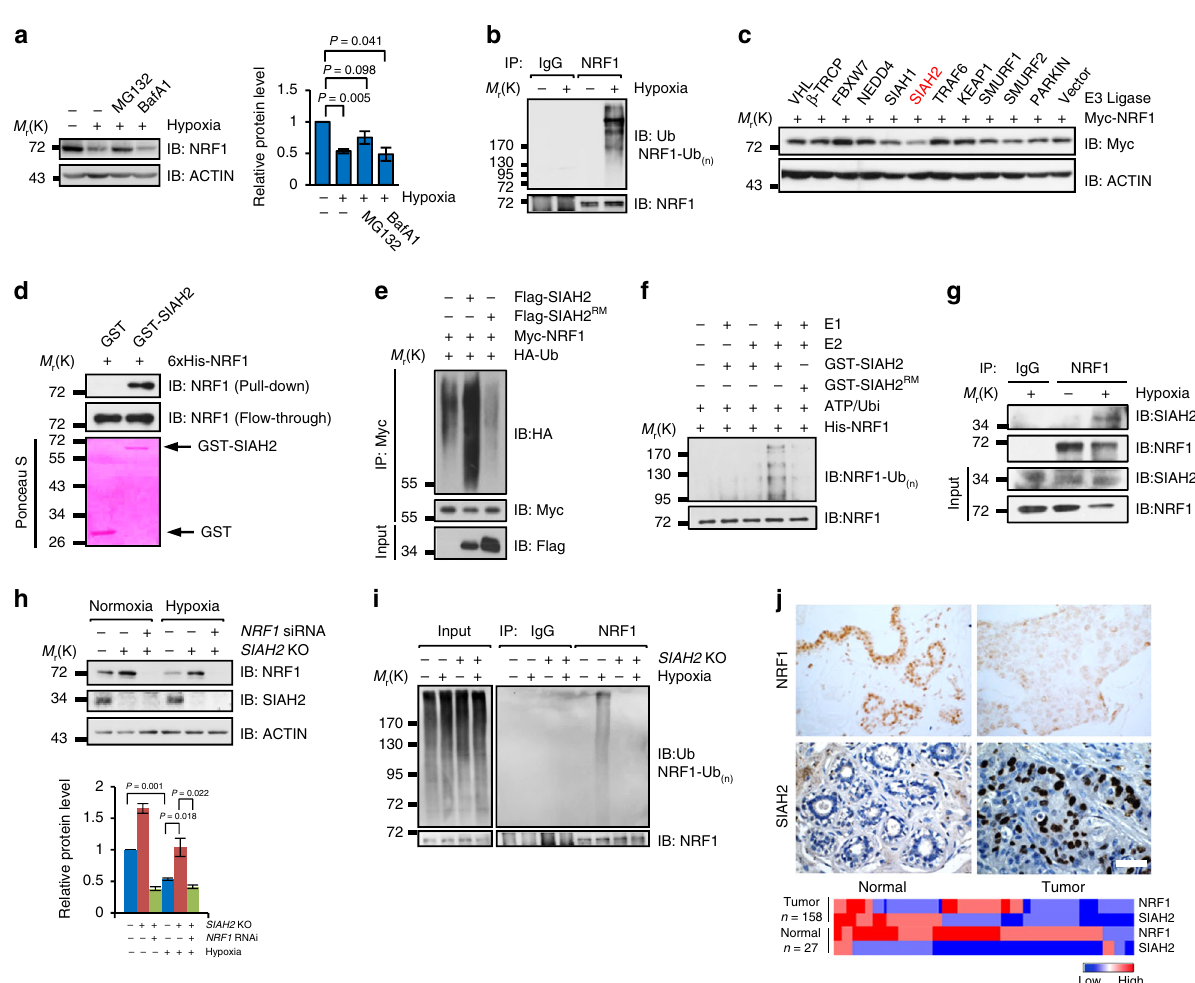
Fig. 3 SIAH2 promotes NRF1 polyubiquitination and degradation under hypoxia. a Hypoxia-mediated NRF1 degradation is inhibited by the proteasomal inhibitor MG132, but not by the autophagy inhibitor Ba fi lomycin A1 (BafA1). Right: densitometric quanti fi cation of NRF1 expressions. b MDA-MB-231 cells were incubated under normoxia or hypoxia for 24 h. Cells were treated with 10 µ M MG132 for 6 h before harvesting. Cell lysates were immunoprecipitated with anti-NRF1 antibodies and then detected by western blotting with anti-NRF1 and anti-Ubiquitin antibodies. c Hypoxia-related ubiquitin E3 ligases were transiently co-transfected with Myc-NRF1 into HeLa cells for 24 h, and Myc-NRF1 protein levels were detected by western blotting with anti-Myc antibodies. d Direct interactions between bacterially expressed His-NRF1 and GST-SIAH2 in vitro. e Ectopic expression of SIAH2, but not SIAH2 RM increased NRF1 ubiquitination in vivo. f Ubiquitination of bacterially expressed His-NRF1 by puri fi ed SIAH2 but not by SIAH2 RM in vitro. g MDA-MB-231 cells were cultured under normoxia or hypoxia for 18 h, then treated with 10 µ M MG132 and incubated under normoxia or hypoxia for another 6 h. Endogenous interactions between NRF1 and SIAH2 were analyzed by immunoprecipitation. h Wild-type or SIAH2 − / − MDA-MB-231 cells were transiently transfected with scramble or NRF1-targeted siRNA, and then cultured under normoxia or hypoxia for 36 h. Cells were harvested and analyzed by western blotting. Bottom: densitometric quanti fi cation of the indicated proteins. i Hypoxia-induced ubiquitination of NRF1 is abolished by depletion of SIAH2 in vivo. j Top: representative immunohistochemical staining of NRF1 and SIAH2 in normal breast tissue and breast cancer tissue from the tissue microarray. (Brown color indicates positive immune reaction; scale bars, 50 µ m). Bottom: heat map showing quantitative analysis of the expression of NRF1 and SIAH2 proteins in normal breast tissues and breast cancer tissues. n = 158 breast tumors and n = 27 normal breast samples. Statistical analysis of the immunostaining results is shown in Supplementary Table 3, 4. For all panels, error bars indicate s.d., n = 3 biological replicates. Data were compared with two-tailed